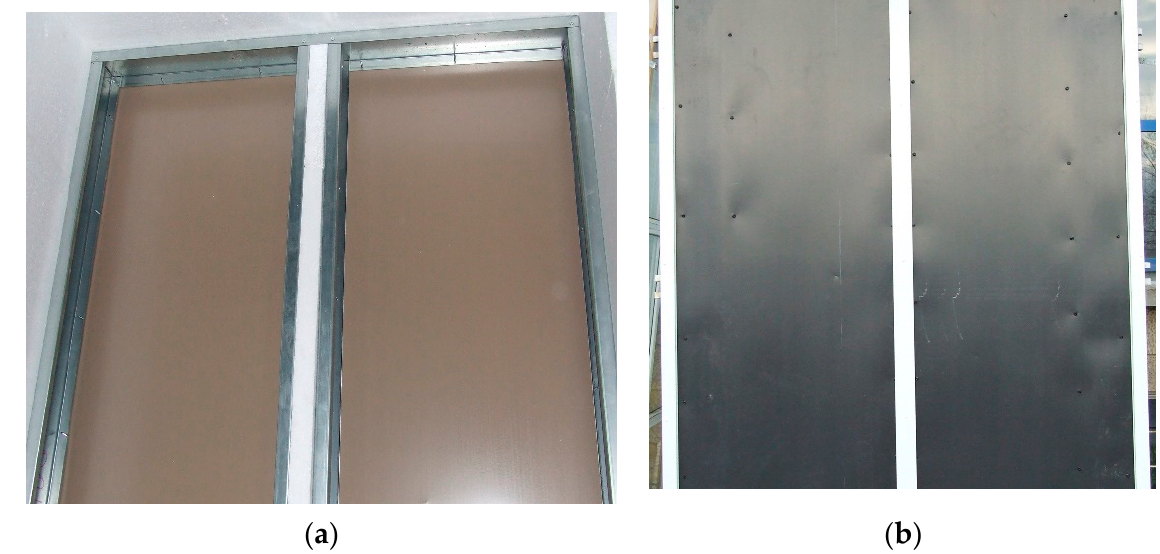
Figure 3. View of the steel structure and the absorber: ( a ) from the inside of the chamber; ( b ) from the outside.